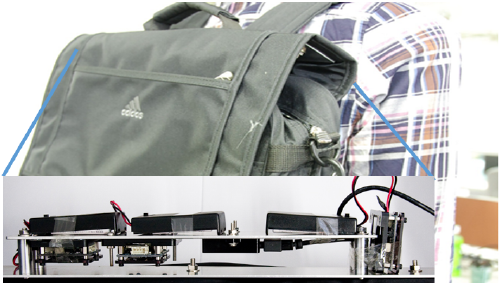
Figure 4. An example of three IMUZ sensors in the backpack for the test dataset. The sensors are attached to the top of the backpack.